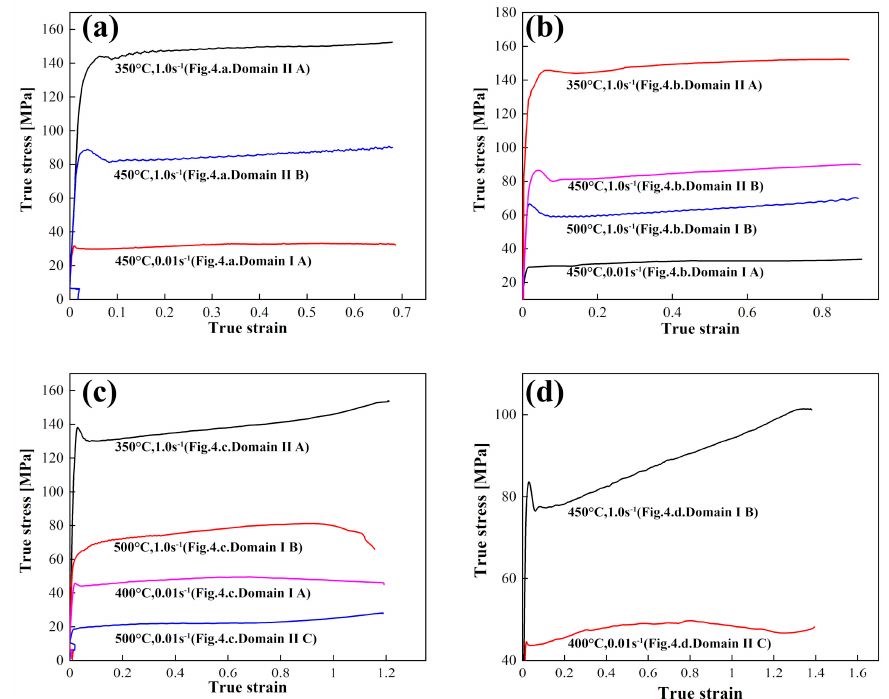
Figure 7. Stress-strain curves after deformation at true strains of ( a ) 0.69, ( b ) 0.92, ( c ) 1.20 and ( d ) 1.38.